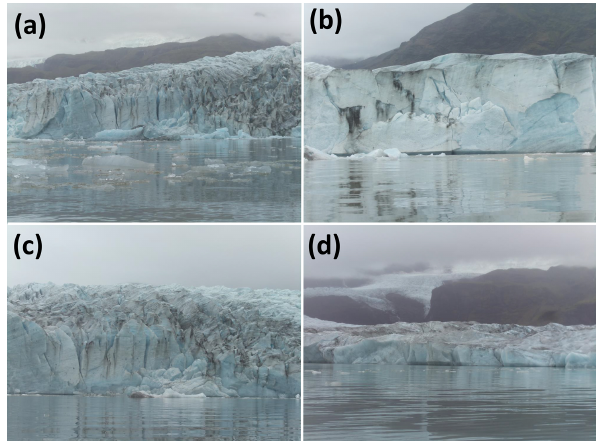
Figure 3. Example images captured by the Raspberry Pi sensor. Im- ages A, B, and C are taken from the boat transect ( ∼ 500m from the glacier front) and have an approximate field of vision of ∼ 100m, while D is captured from the shoreline ∼ 1 . 2km from the glacier, with an approximate field of vision of ∼